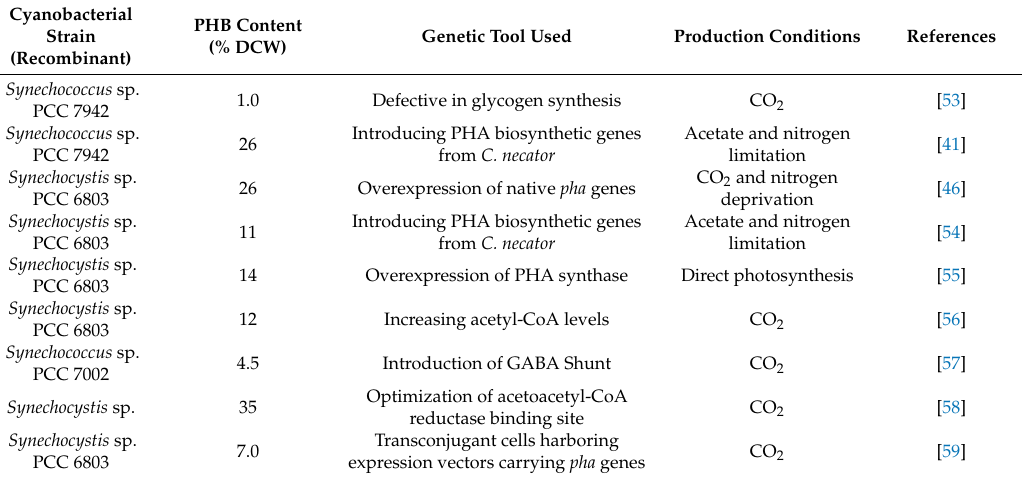
Table 2. Strategies to increase PHB biosynthesis